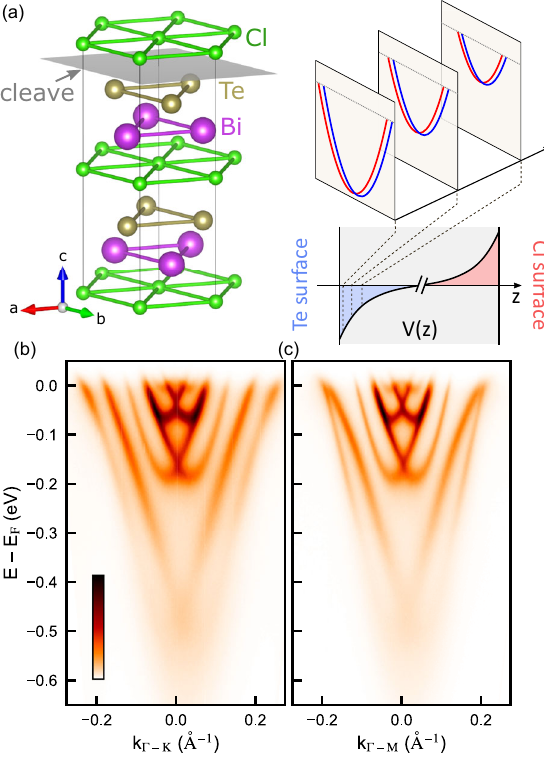
Fig. 1 Surface electronic structure of BiTeCl. a Crystal structure and schematic of the bands localized near the Te-terminated surface due to a depth-dependent potential V ( z ). Each sub-band shows a Rashba-like spin splitting. b , c Spin-integrated ARPES measurements of the Te-terminated surface along Γ -K and Γ -M, respectively, revealing the sub-band structure. cleavage process 10,13,15 . The band-bending potential V ( z ) splits off surface sub-bands, each of which undergoes spin-splitting, as sketched in the right side of Fig. 1a. In this paper we focus on the Te-terminated surface, since its surface sub-band at the deepest binding energy has been identi fi ed as a potentially ideal Rashba system due to its predicted strong splitting, isotropic dispersion, and energetic separation from bulk states 10 . Our ARPES measurements along the Γ -K and Γ -M directions are shown in Fig. 1b, c, respectively. Comparison of the two spectra indicates that the band dispersions are largely isotropic, with a Fig. 2a. The measured in-plane spin-polarization along Γ -K and Γ -M is represented in a 2-dimensional colorscale in (b) and (d), respectively. In (c) and (e) we extract the spin-up I ↑ and spin-down I ↓ intensities, plotted as normalized momentum distribution curves (MDCs), with triangles inserted as guides to the eye to denote the peak positions of the outermost sub-band pair. The overall spin-polarization behavior indicates that each sub- band independently undergoes spin-splitting, as suggested in Fig. 1a. However, closer examination reveals a discrepancy from the Rashba model: the spin-polarization along Γ -K abruptly reverses sign in the outermost sub-band near E F . This anomaly is clearly